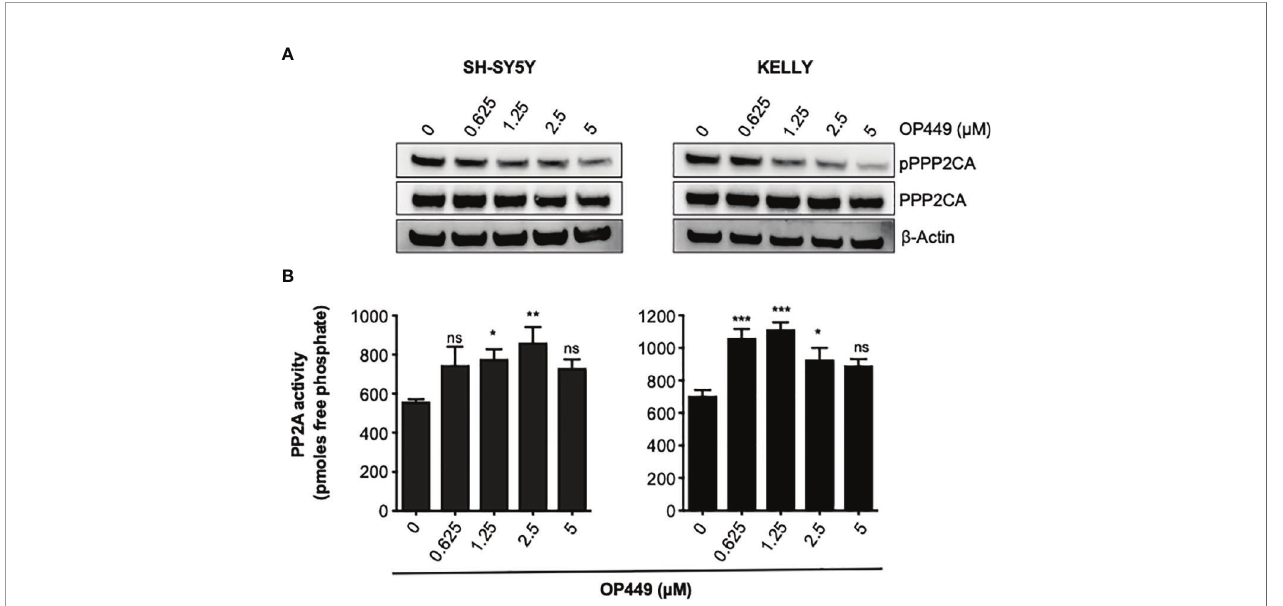
FIGURE 5 | OP449 reactivates PP2A in neuroblastoma (NB) cells. (A) OP449 dephosphorylates PPP2CA at Y307. SH-SY5Y and KELLY NB cells were treated for 4 h with increasing concentrations of OP449. Western blotting for pY307 of PPP2CA and for PPP2CA is shown. b -Actin was used as loading control. Full-length Western blotting is shown in Supplementary Figure 2B . (B) OP449 reactivates PP2A. Cells were treated for 4 h with increasing concentrations of OP449 and lysed. PPP2CA was immuno-precipitated, and PP2A activity was determined by colorimetric assay. Experiments were repeated three times. Data are expressed as means ± SEM of triplicates and are analyzed by one-way ANOVA test. * p < 0.05, **p < 0.01, ***p < 0.001; ns, not signi fi